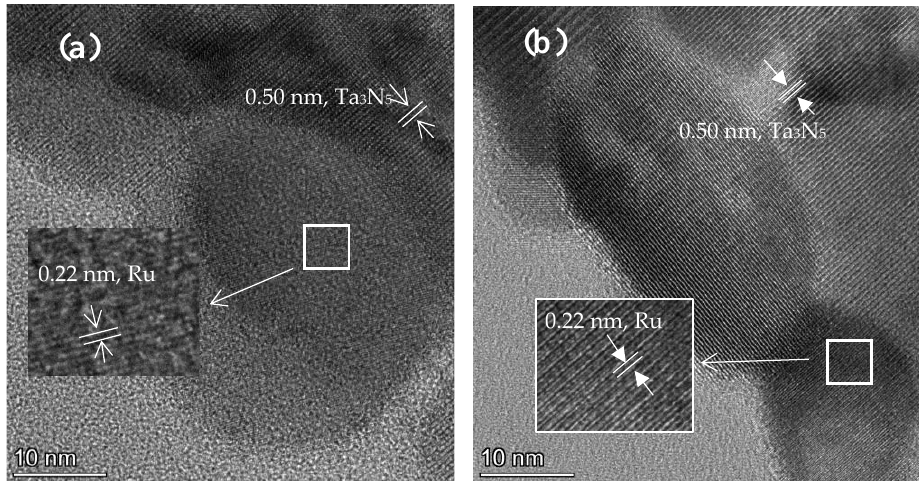
Figure 2. ( a , b ) HRTEM images of 5 wt% Ru/Ta 3 N 5 NBs. To find the optimal load for Ru, we prepared Ru/Ta 3 N 5 NB catalysts with different mass fractions of Ru (1 wt%, 3 wt%, 7 wt%, and 10 wt%). Figure 3a – d show SEM images of those, respectively, and the XRD patterns are shown in Figure S1, which are indexed as orthogonal Ta 3 N 5 (JCPDS no. 79-1533). Because Ru NPs are too little or the strong peak (2θ: 44°) of Ru overlaps with that of Ta 3 N 5 , it is difficult to observe the Ru peak. Figure 3. SEM images of ( a ) 1 wt% Ru/Ta 3 N 5 NBs, ( b ) 3 wt% Ru/Ta 3 N 5 NBs, ( c ) 7 wt% Ru/Ta 3 N 5 NBs, and ( d ) 10 wt% Ru/Ta 3 N 5 NBs. 2.2. The Surface Properties Figure 4a – d present the X-ray photoelectron energy spectroscopy (XPS) of Ru NPs, Ta 3 N 5 NBs, and 5 wt% Ru/Ta 3 N 5 NBs. Figure 4a shows the XPS survey spectra of those, which further confirm the existence of Ru, N, and Ta in 5 wt% Ru/Ta 3 N 5 NBs. As shown in Figure 4b, the peaks at 396.23 eV and 403.28 eV of 5 wt% Ru/Ta 3 N 5 NBs correspond to the binding energies (BEs) of N 1s and Ta 4p 3/2 , respectively, while the peaks at 395.89 eV and 403.11 eV of Ta 3 N 5 NBs correspond to the BEs of N 1s and Ta 4p 3/2 [32,33], respectively. Figure 4c presents the fine XPS spectra of Ta 4f of the Ta 3 N 5 and 5 wt% Ru /Ta 3 N 5 NBs. The two peaks at 24.21 and 26.17 eV of 5% Ru/Ta 3 N 5 correspond to the BEs of Ta 4f 7/2 and